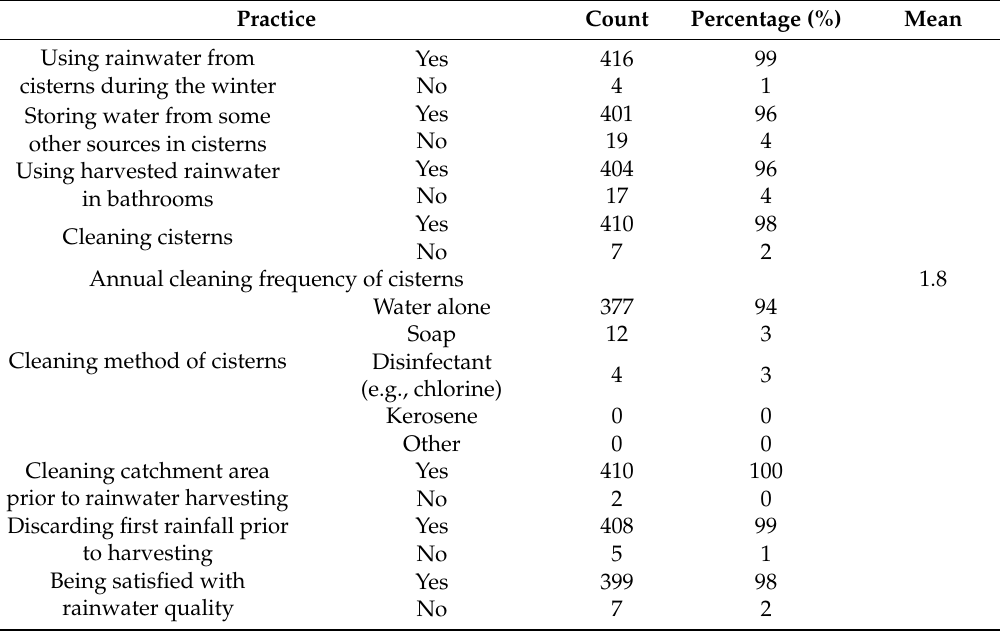
Table 2. Some environmental conditions surrounding the RWH